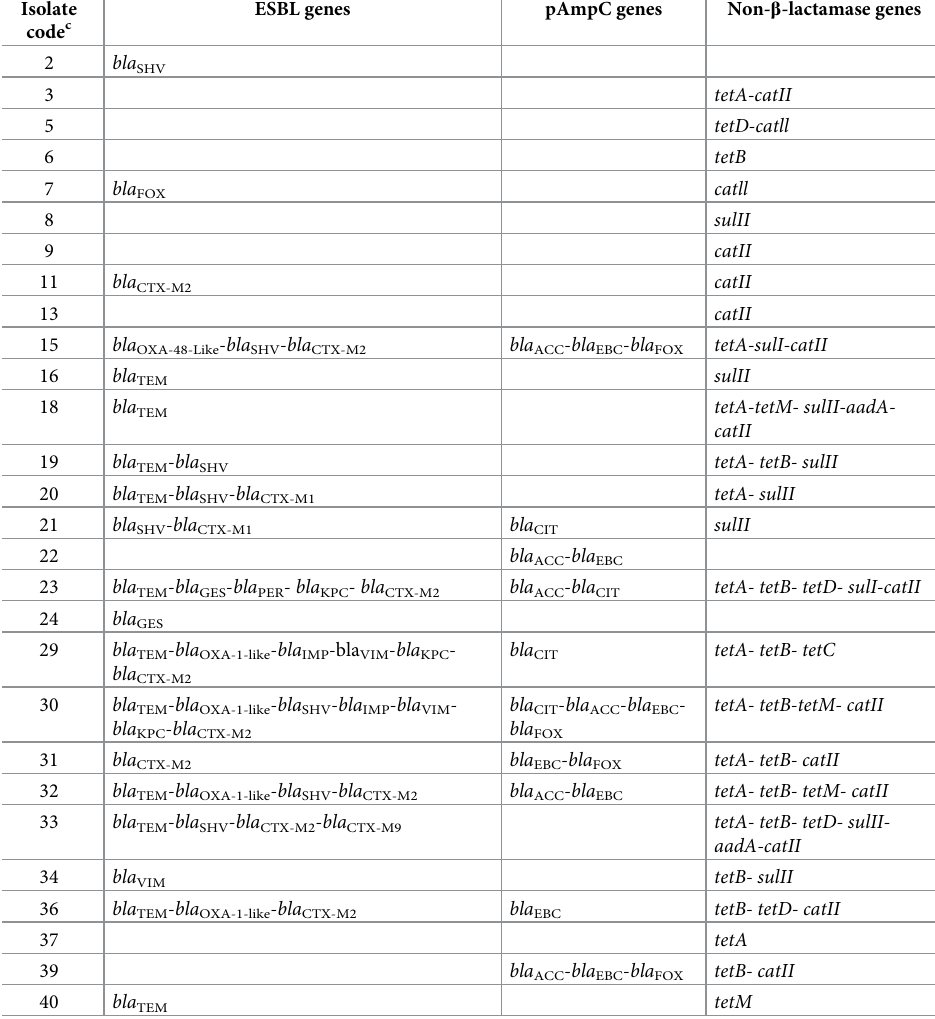
Table 3. Extended-spectrum and plasmid-mediated AmpC β -lactamases and non- β -lactamase genotypes detected in multidrug-resistant